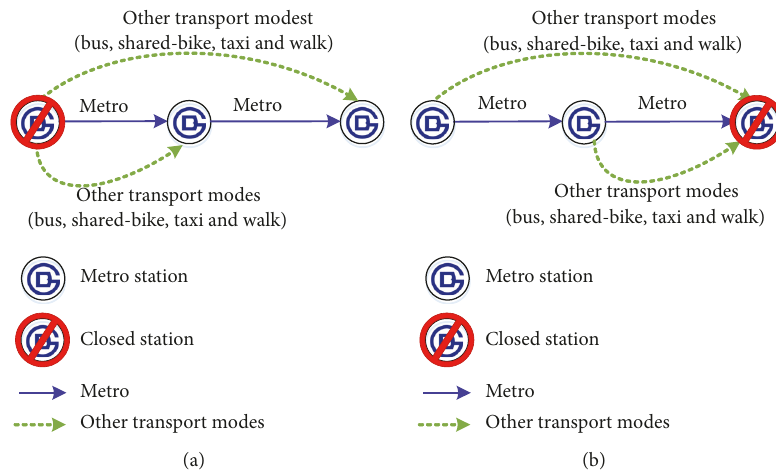
Figure 3: The two station disruption situations and likely choice behaviorfor a passenger. (a) shows the situation wherethe passenger’s origin station is closed. (b) shows the situation that the passenger’s destination station is